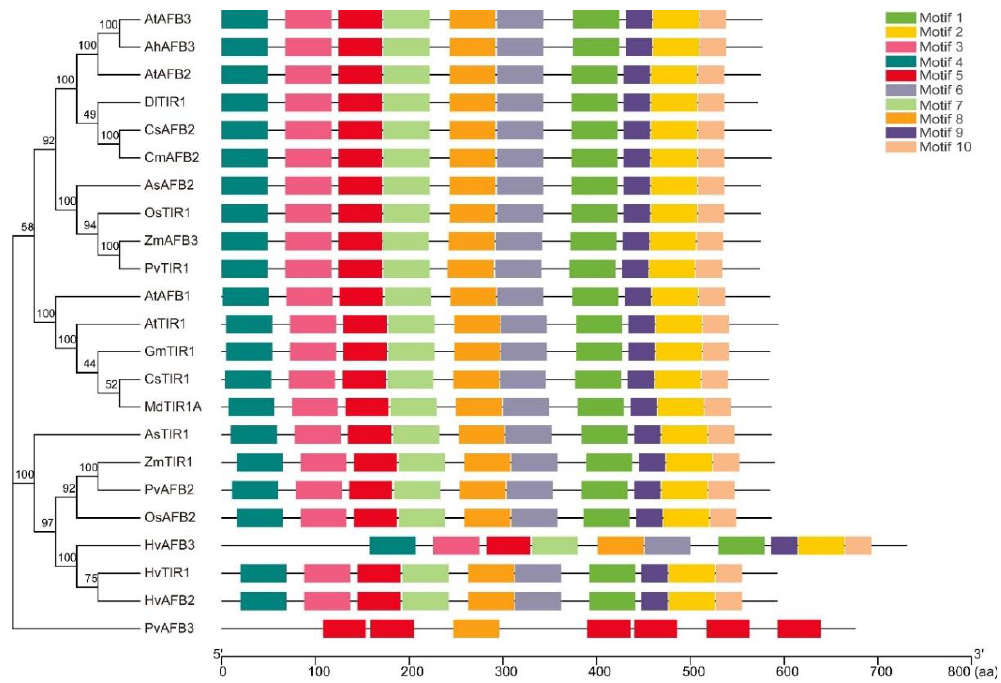
Figure 2. Phylogeny and structures of functionally characterized TIR1/AFBs in plants. Ah, Arachis hypogaea ; At, Arabidopsis thaliana ; As, Agrostis stolonifera ; Cm, Cucumis melo ; Cs: Cucumis sativus ; Dl: Dimocarpus longan ; Gm, Glycine max ; Hv, Hordeum vulgare ; Md, Malus × domestica ; Os, Oryza sativa ; Pv, Panicum virgatum ; Zm, Zea mays .